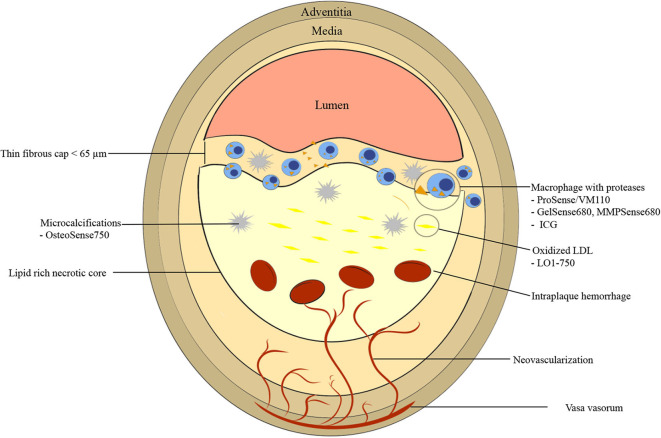
Graphic representation of vulnerable plaque characteristics with emphasis on near-infrared fluorescence (NIRF) molecular imaging targets. High risk features include thin fibrous cap <65 μm, fibrous cap and necrotic core macrophages, large necrotic core, microcalcifications, neovascularization, and intraplaque hemorrhage. ICG, indocyanine green.